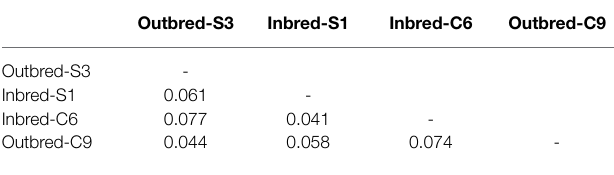
TABLE 2 | Genetic differentiation, based on Fst index, of the crossbred female Nile